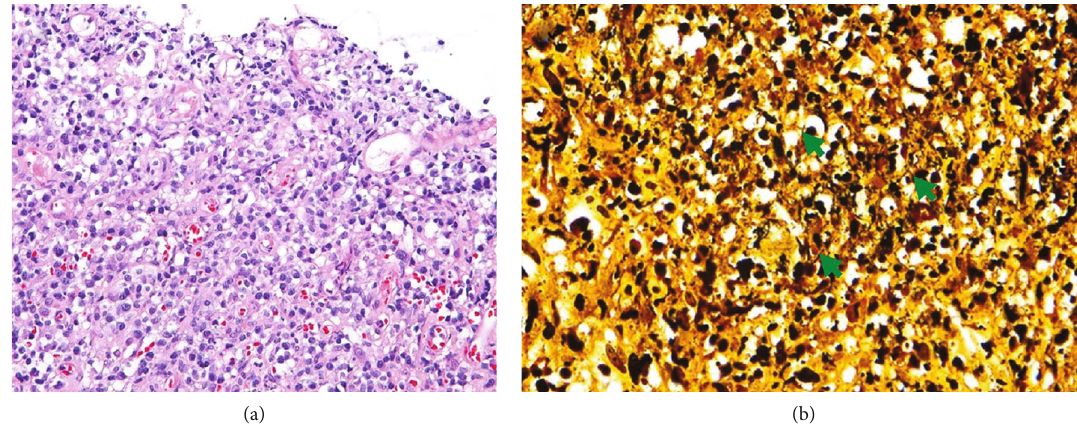
Figure 11: Histopathologic fi ndings demonstrate a rectal ulcer with in fl ammation with a predominance of plasma cells (a). Warthin-Starry stain demonstrates numerous spirochetes with spiral rods (arrows in (b)). (Images obtained with permission from You et al.